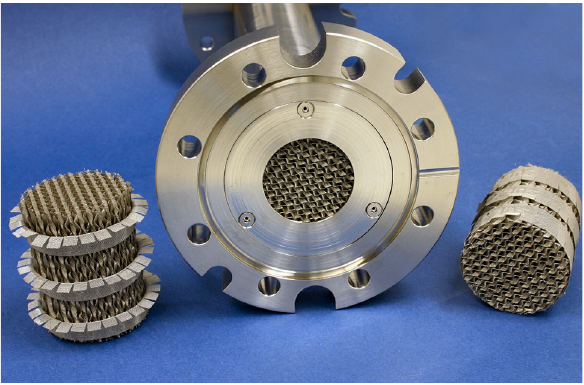
Fig. 4 Package tube. After a cleaning procedure, the structured pack- age material is filled into the package tube inside a clean-room